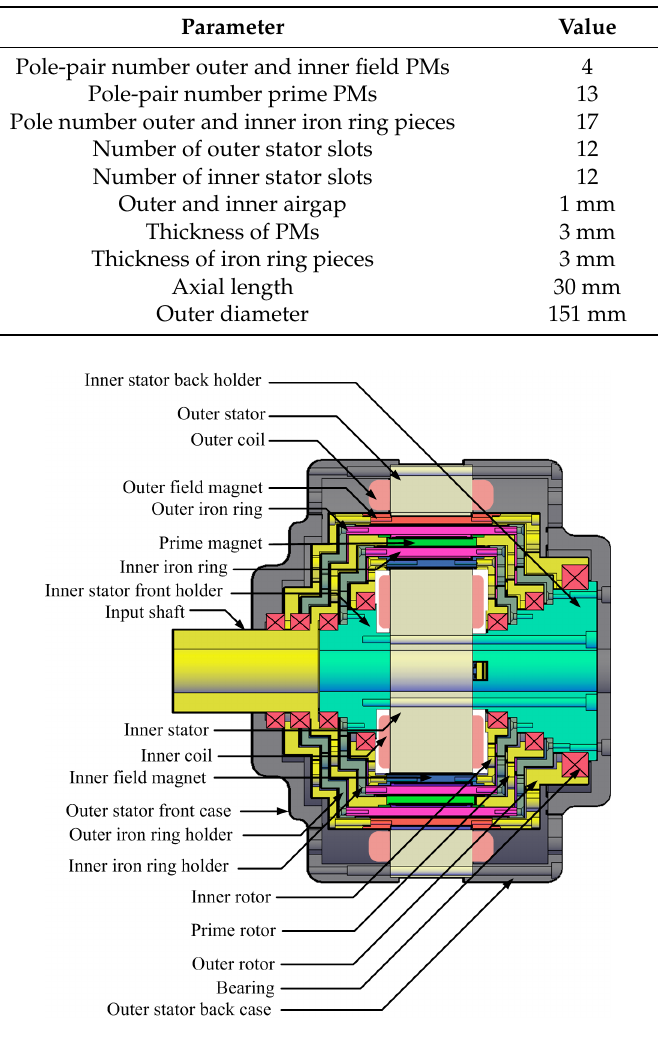
Figure 2. Axial cross-sectional diagram of the magnetic geared double-stator machine.